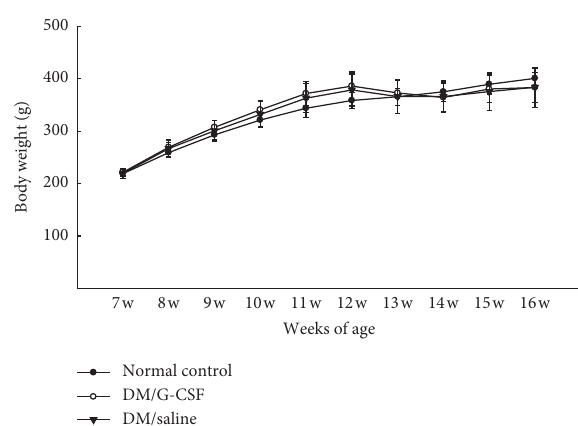
Figure 2: Changes in body weight . Alterations of body weight in Sprague–Dawley rats were monitored during the entire experi- mental period. DM, diabetes mellitus. All data are expressed as mean ± standard deviation ( n � 8 per